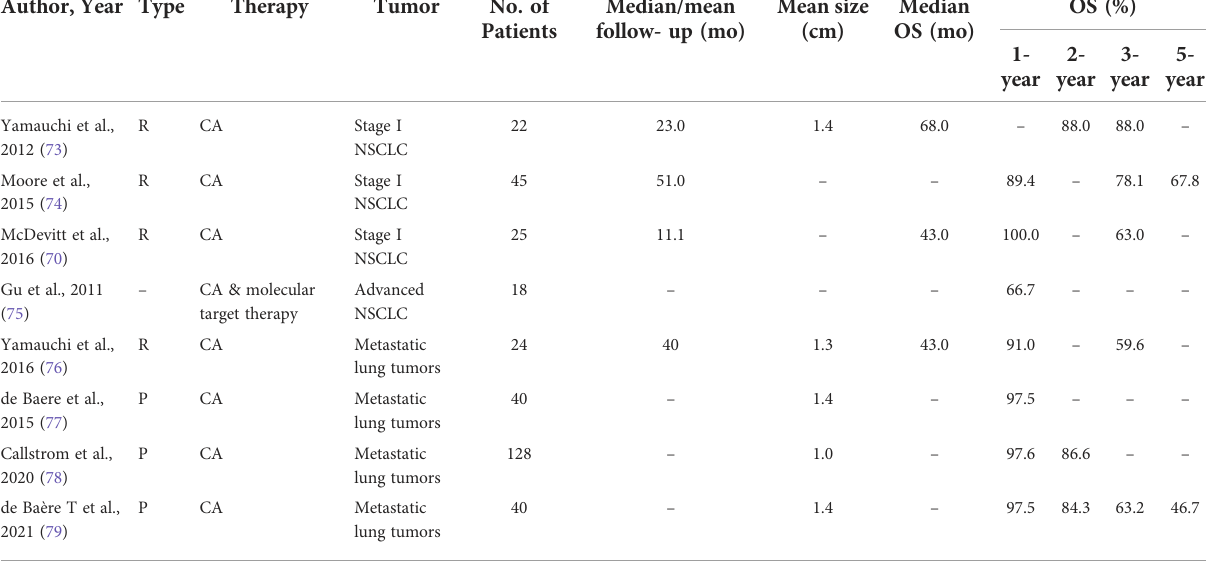
TABLE 3 Summary of published studies of CA in lung tumors. Author, Year